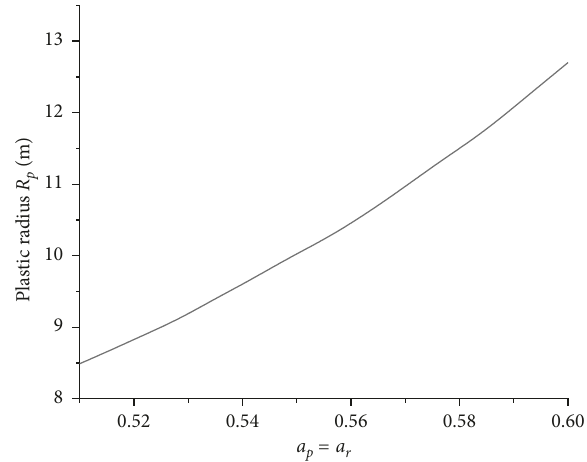
Figure 17: Variation of plastic radius R with the change of a .